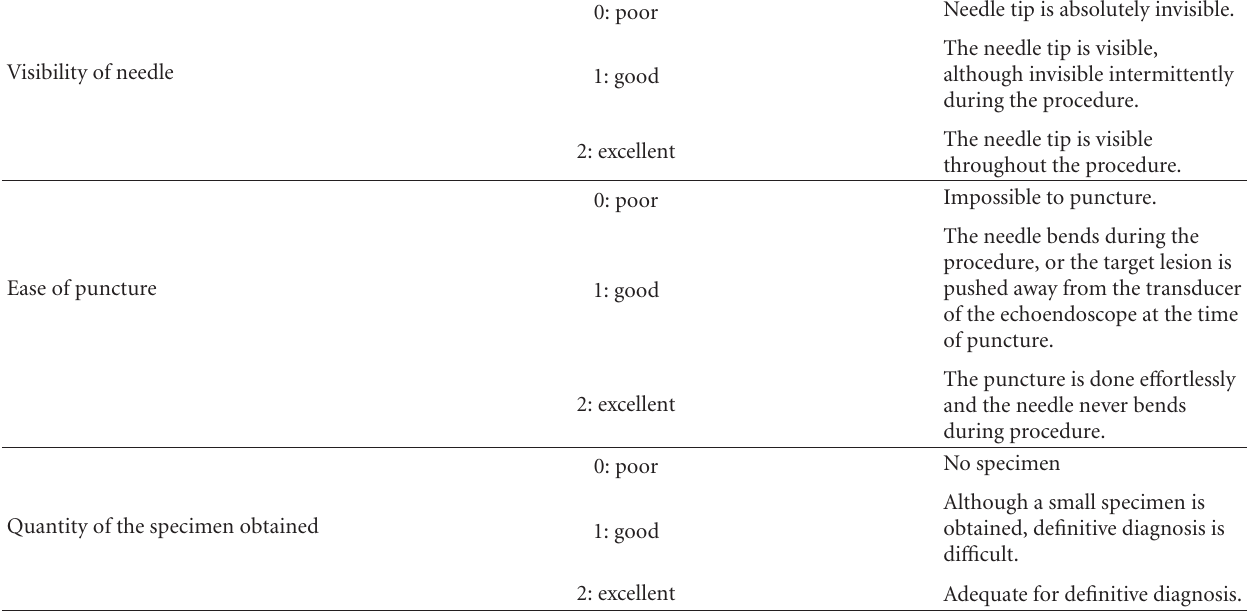
Table 1: Scoring of visibility of needle, ease of puncture, and quantity of specimen obtained.